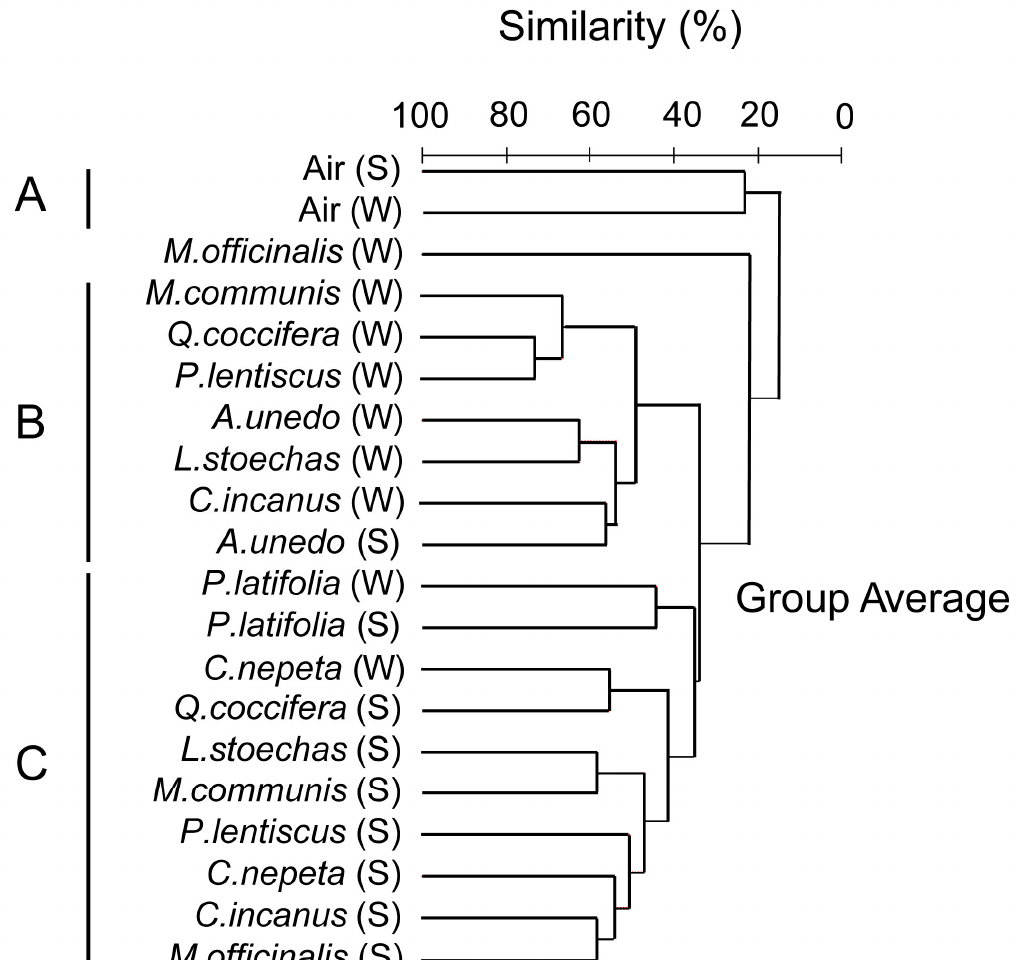
Figure 3. Cluster diagram based on Bray–Curtis dissimilarities calculated according to the number of reads of bacterial OTUs that were detected in the phyllosphere and in the air of the Mediterranean ecosystem studied; (S) represents summer samples and (W) winter samples. Three major clusters are formed: cluster A is made of air samples, whereas B and C are made of phyllosphere samples, primarily winter and summer ones, respectively.